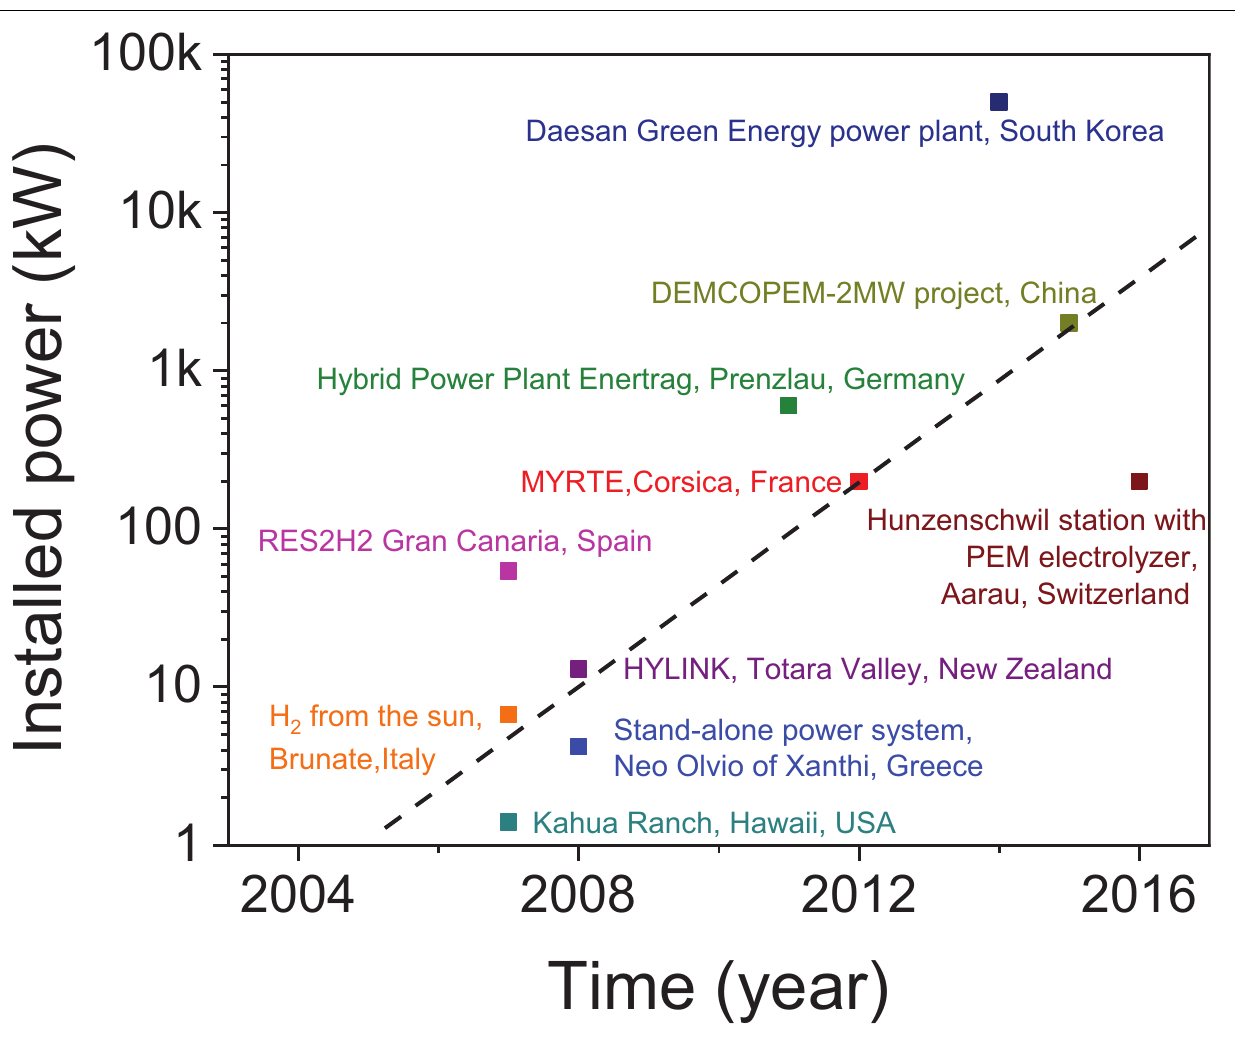
FIGURE 1 | In-operation power-plants producing hydrogen from electricity (Ipsakis et al., 2009; Schoenung, 2010; Ziogou et al., 2011; Darras et al., 2012; Gahleitner, 2013; Fuel Cells Bulletin, 2014, 2016a,b, 2018a,b).